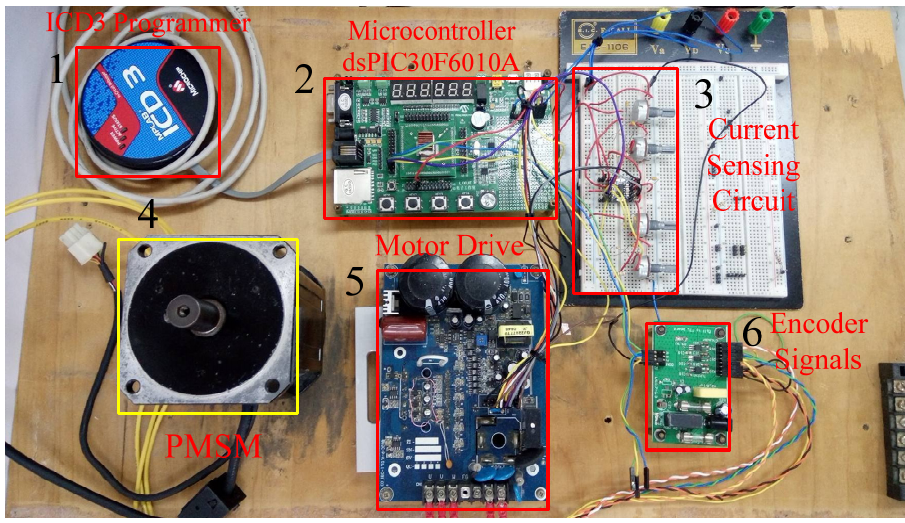
Figure 7. The experimental setup.